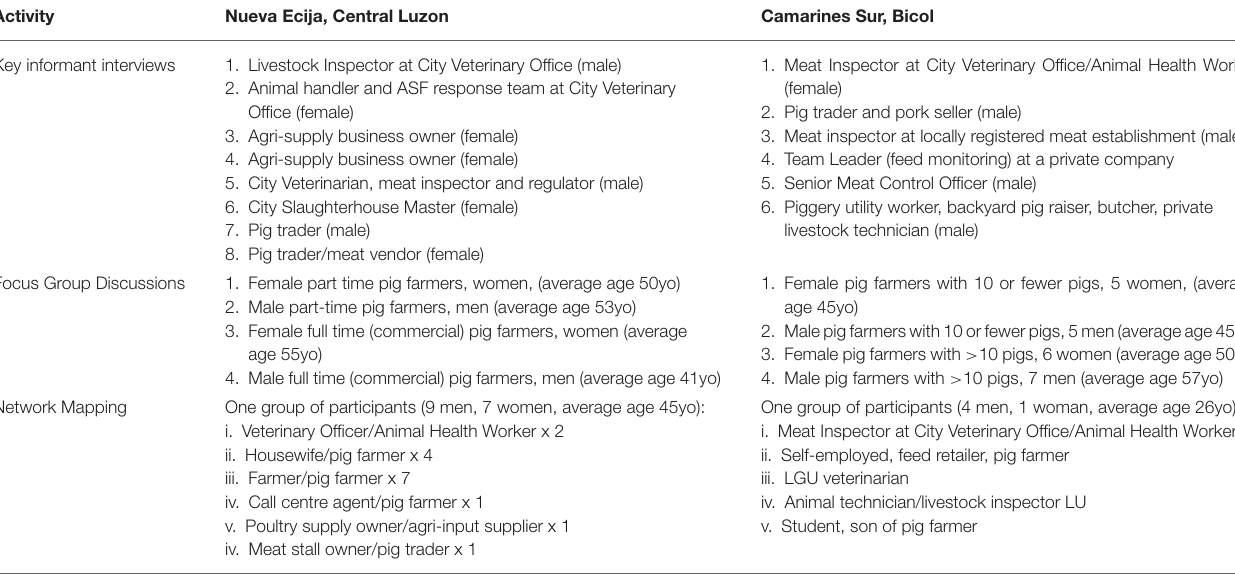
TABLE 1 | Activities conducted and details of participants in each study location.